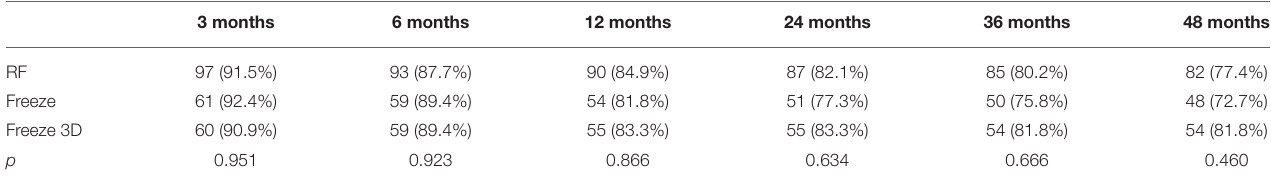
TABLE 2 | Sinus rhythm after different periods of follow-up in the 3